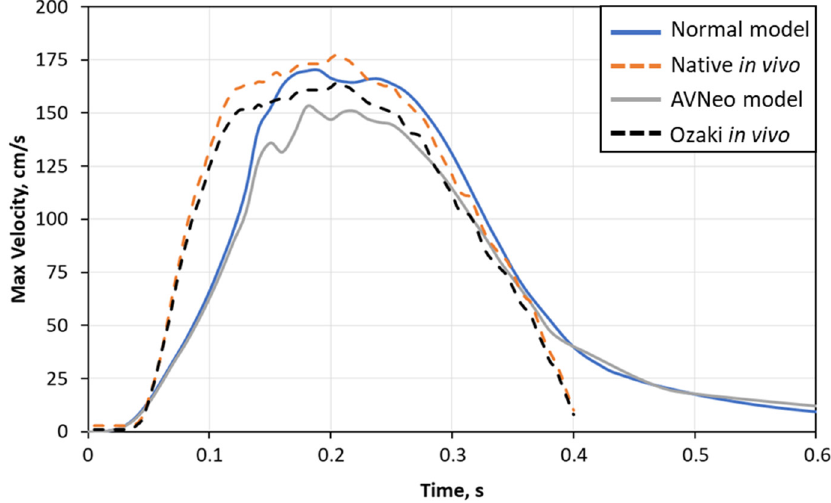
Figure 4. Comparison between peak velocity from model and in vivo experimental data [78].